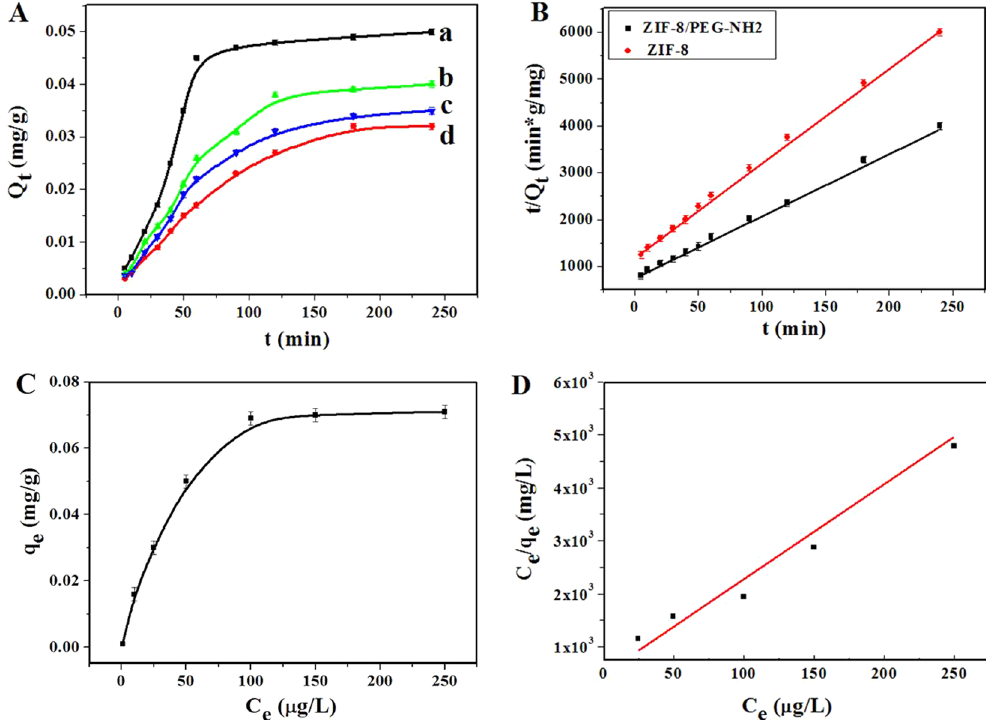
Figure 7. ( A ) Adsorption amount of 4-nonylphenol versus contact time in aqueous solution by using (a) ZIF-8/ PEG-NH 2 membrane, (b) ZIF-8 membrane and (c) PDMS/DVB coating; adsorption amount of bisphenol A versus contact time in aqueous solution by using (d) ZIF-8/PEG-NH 2 membrane. ( B ) The pseudo-second- order kinetic plot for the adsorption (analyte concentration: 50 μ g/L). ( C ) Adsorption isotherm curve of 4-nonylphenol along with ( D ) the linear regression by fitting the equilibrium adsorption data with the Langmuir adsorption model for